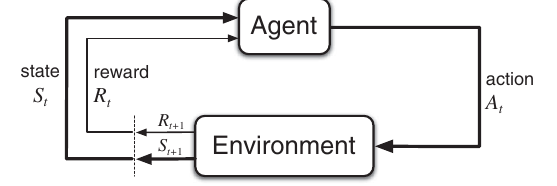
FIG. 4. The agent-environment interaction in a Markov deci- sion process [11]. The agent executes a policy that selects an action A t given the current S t , which results in a reward R t and þ 1 a new state S t of the þ 1